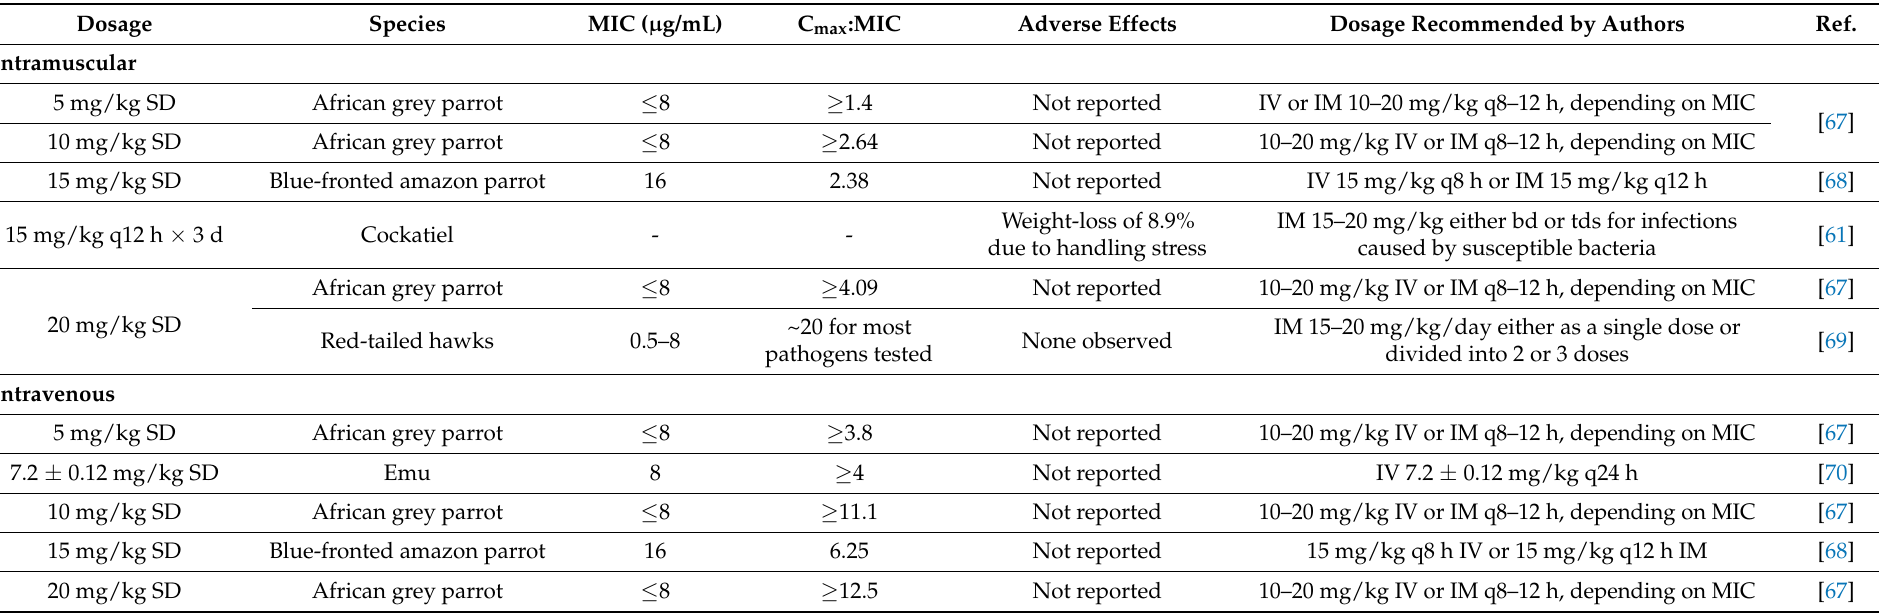
Table 8. Adverse effects, efficacy parameters and dosage recommendations of amikacin in exotic avian species.